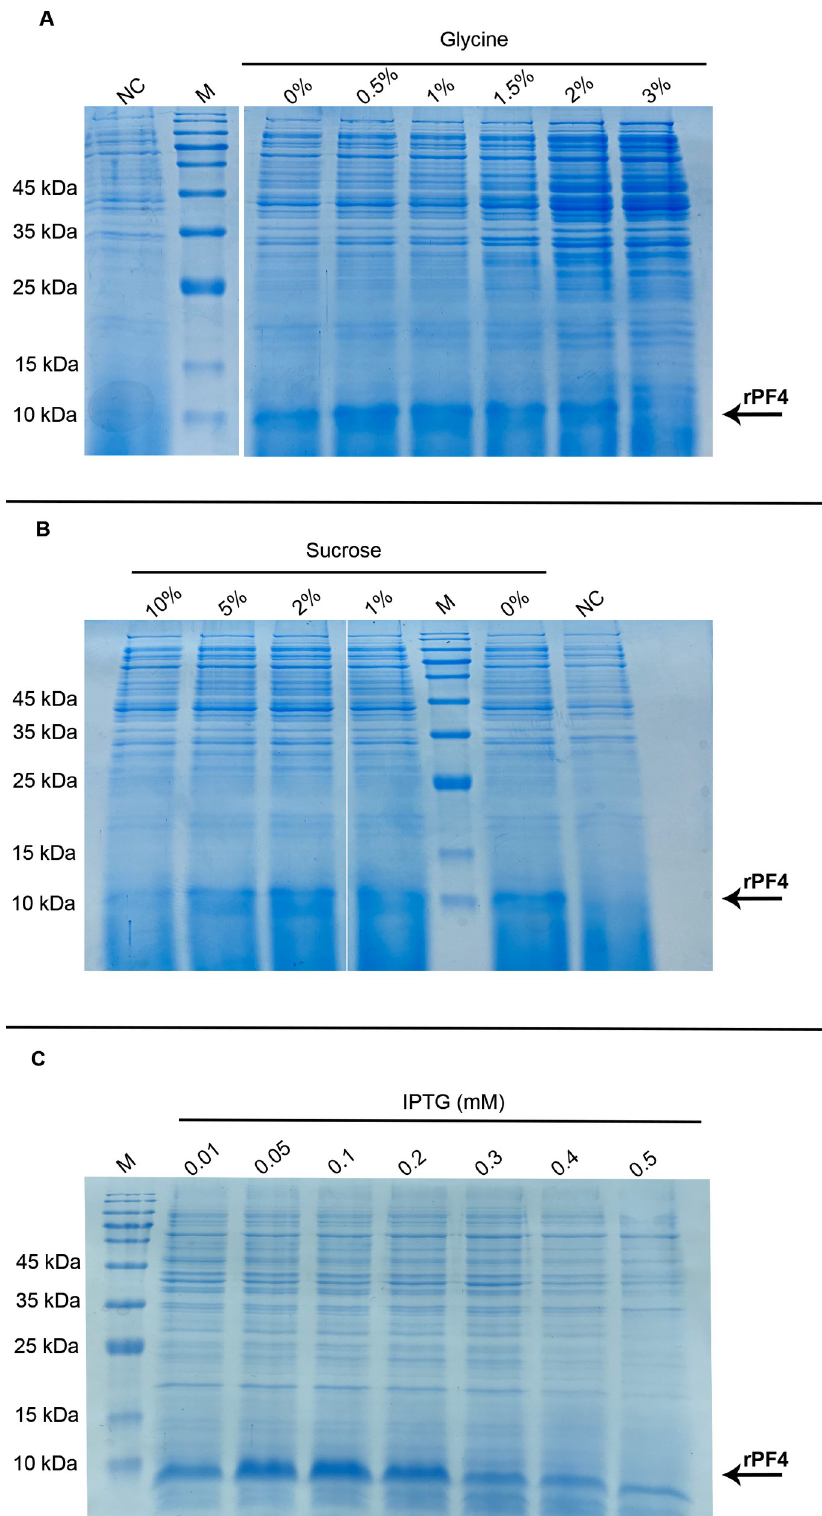
Fig 7. The individual effect of various chemical supplements on protein secretion. (A) Represents the effect of glycine supplementation on protein secretion. Glycine supplementation mildly improved the release of the rPF4 into